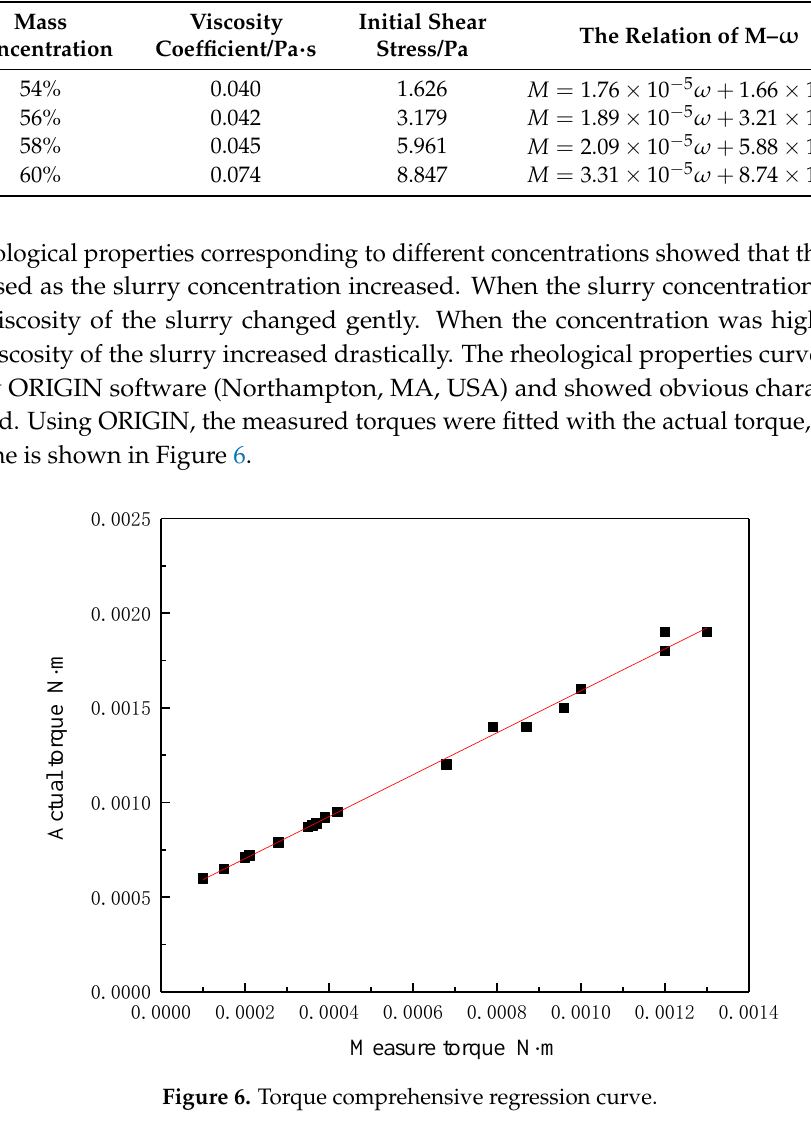
Table 4. Slurry parametric test.